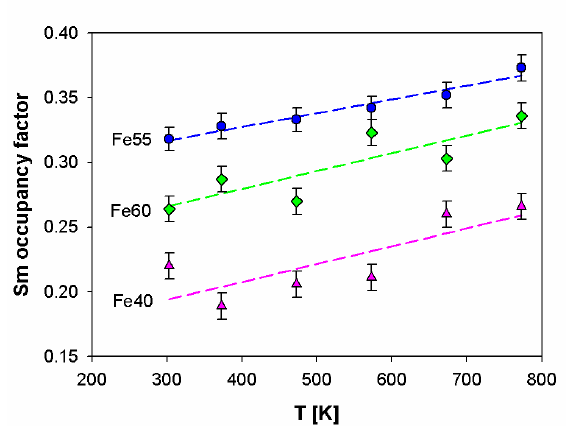
Figure 5. Trend of the Sm occupancy factor in the 2 a site as a function of the temperature for each sample. The dashed lines are the regression lines fitting the experimental points.